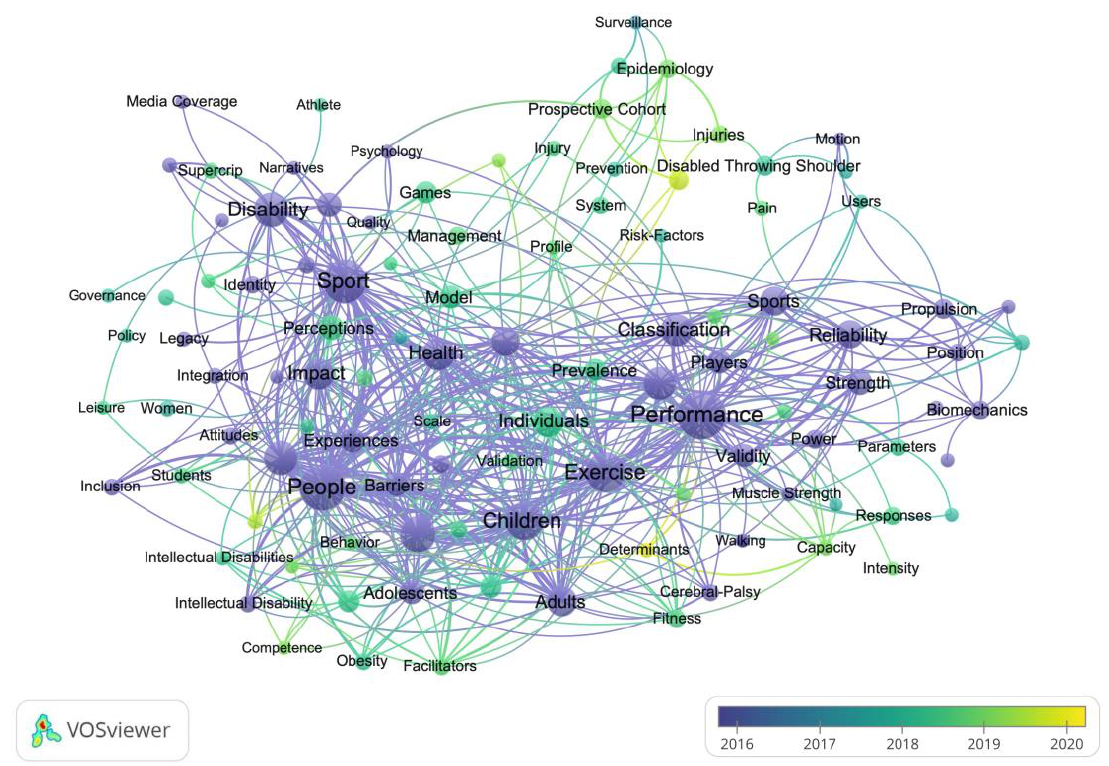
Figure 7. Keywords co-occurrence analysis of adapted sport publications between 2001 and 2020 with timeline.